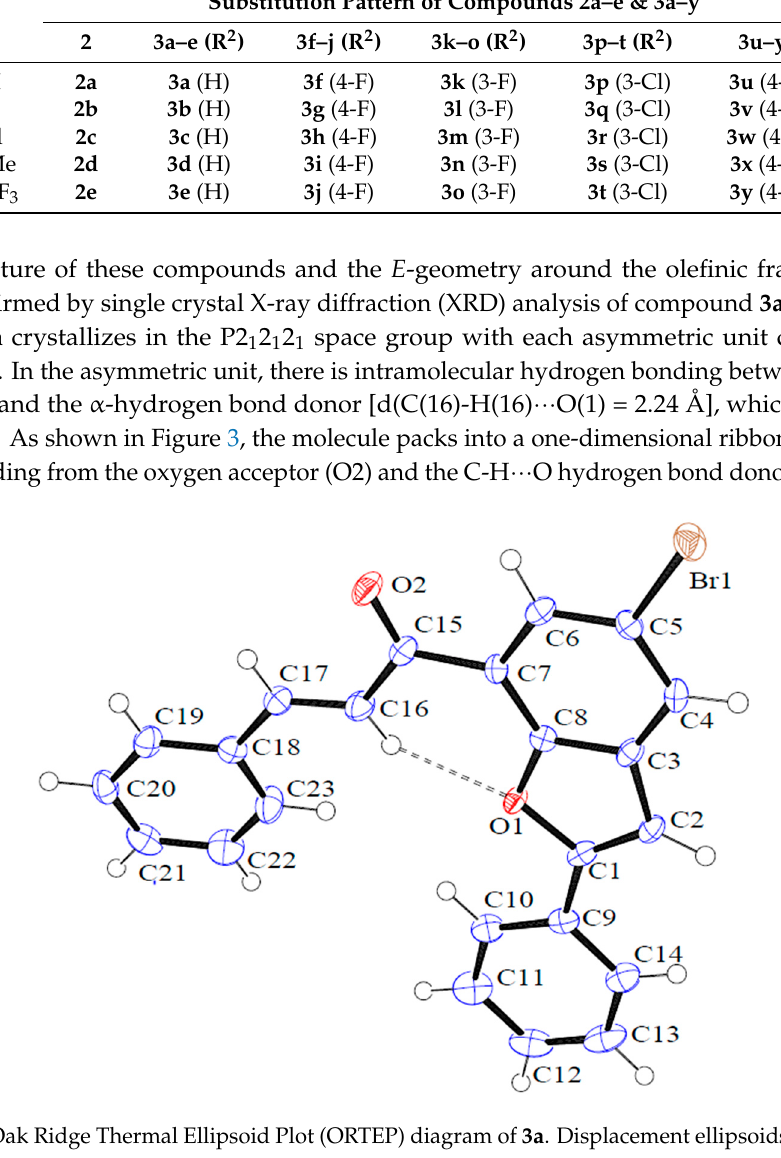
Figure 2. Oak Ridge Thermal Ellipsoid Plot (ORTEP) diagram of 3a . Displacement ellipsoids are drawn at the 50% probability level and H atoms are shown as small spheres of arbitrary radii.